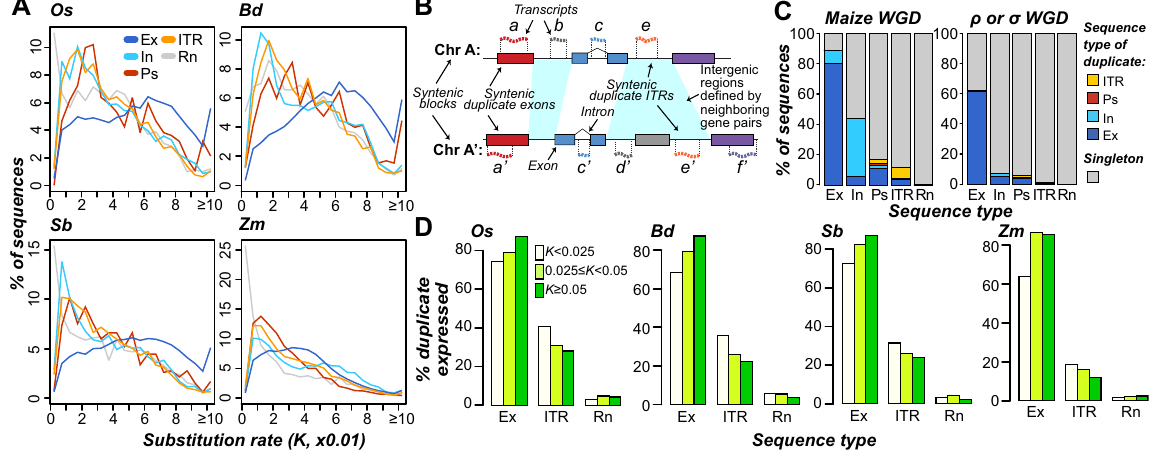
Figure 4. Duplication characteristics of transcribed regions. (A) Distributions of nucleotide substitution rates ( K ) between a sequence and its top within-species nucleotide sequence match. (B) Schematic of syntenic duplicate identification method. Syntenic regions from two chromosomes (Chr A and A’) are shown, with duplicate genes indicated by boxes with matching colors and transcripts by wavy, dashed lines. Cyan: intergenic region pair defined by neighboring duplicate pairs. Syntenic duplicates are defined by their expression state and sequence types, including transcribed exon pair (a and a’), transcribed intron pair (c and c’), and ITR pair (e and e’). Also shown are examples of transcribed regions that lack a syntenic duplicate: b, d’, and f’. Note that syntenic paralogs were also identified among non-transcribed sequences in the same manner. For example, if e’ was not expressed, a query with the sequence underlying e would identify similarity to the sequence underlying e’. (C) Proportions of syntenic duplicates from the maize lineage-specific whole genome duplication (Maize WGD; left panel) and ρ / σ WGDs (right panel). Singleton: sequences that have no syntenic duplicate identified. Ps: pseudogene. Other sequence types are abbreviated as in Fig. 3C,D. (D) Percent of expressed duplicates among sequence types in three nucleotide substitution rate ( K ) bins. Species abbreviations follow Fig. 1. Sequence type abbreviations follow Fig.